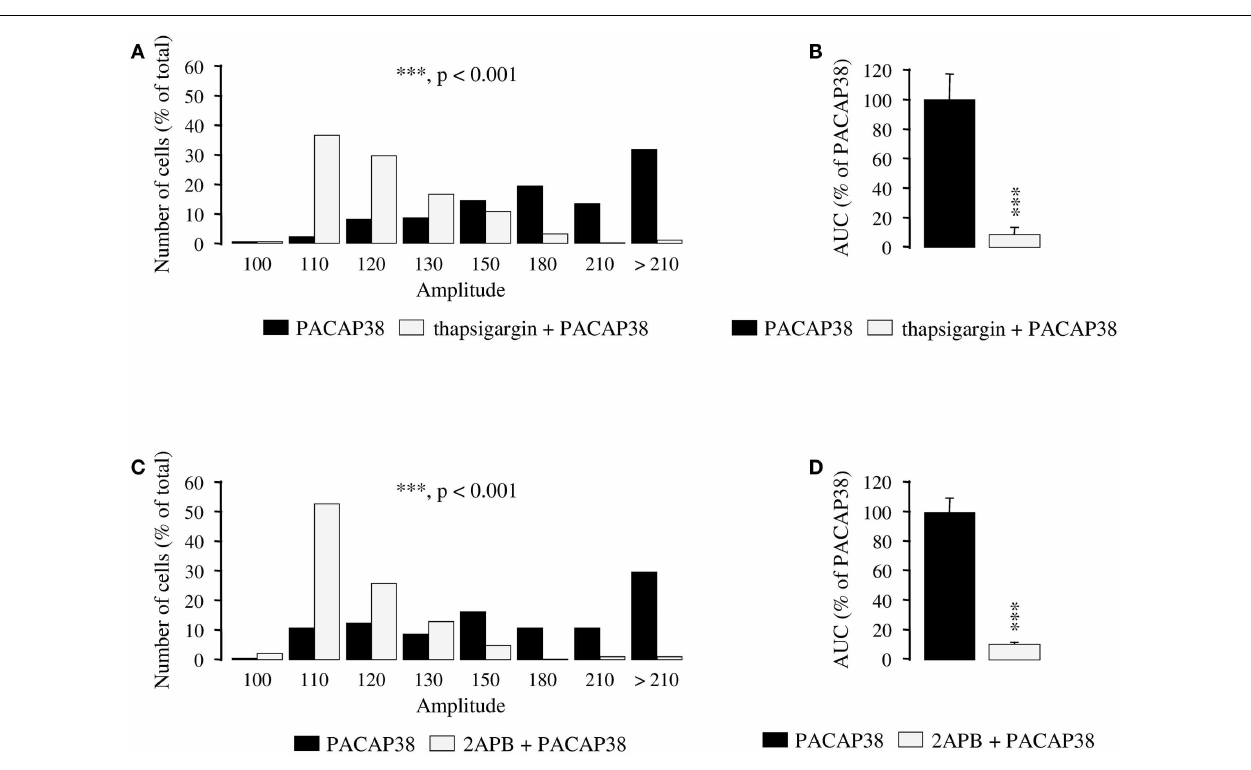
1,4,5-trisphosphate receptor antagonist.Thapsigargin and 2APB were added 15 and 30min before application of the pulse of PACAP, respectively. (A,C) Histograms showing the distribution of granule cells according to the amplitude of their response to PACAP. Each graph represents the analysis of a least 50 cells from 3 different cultures. 2APB, 2-aminoethoxydiphenyl borate; AUC, area under the curve. *** p <